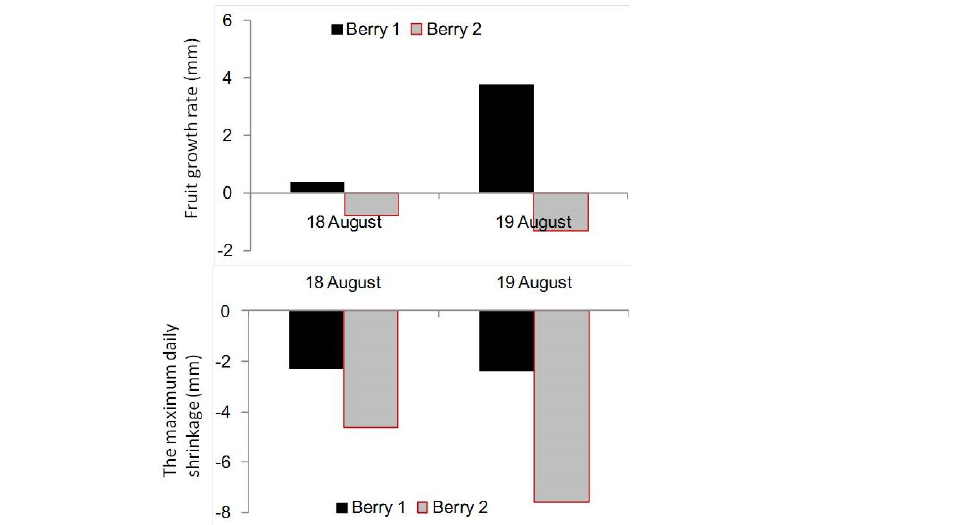
Figure 2. Fruit growth rate (mm) and maximum daily shrinkage (mm). The fruit growth rate was the difference between the maximum diameter of two consecutive days. The maximum daily shrinkage was the difference between the daily minimum diameter minus the maximum diameter of the former day.